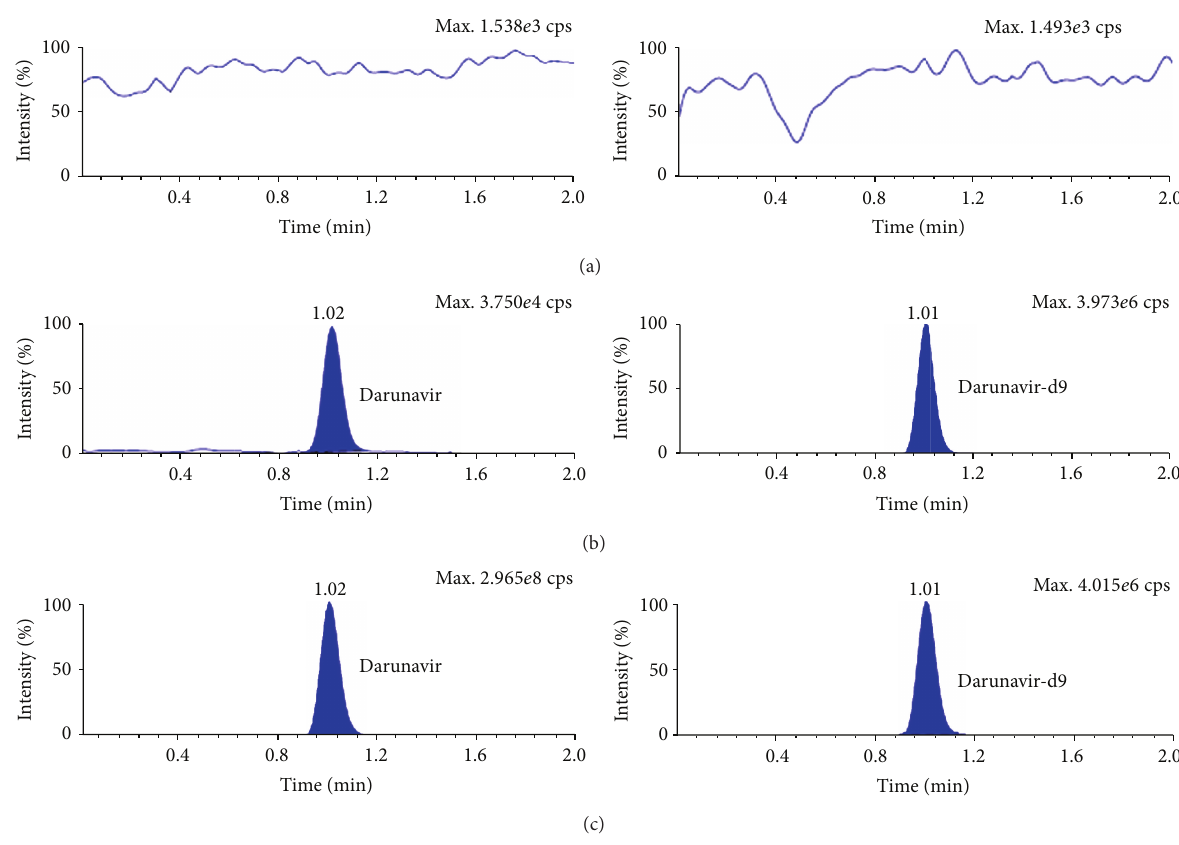
Figure 4: MRM ion chromatograms of darunavir in (a) double blank plasma (without analyte and IS), (b) at LLOQ and darunavir-d9, and (c) in real subject